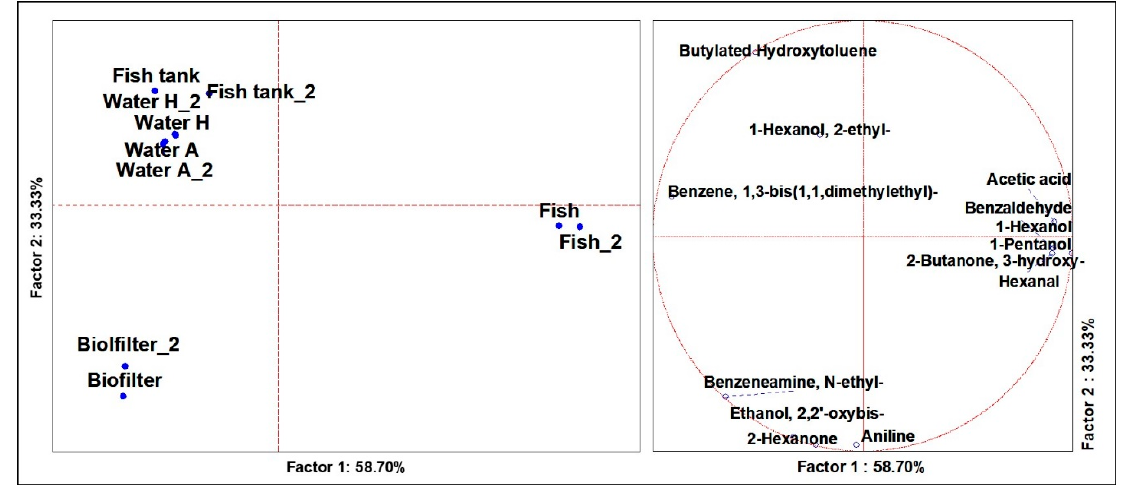
Figure 4. Principal Component Analysis (PCA) of the cases ( left ) and variables ( right ) of the significant (ANOVA p < 0.05) VOCs of the cultivation system.